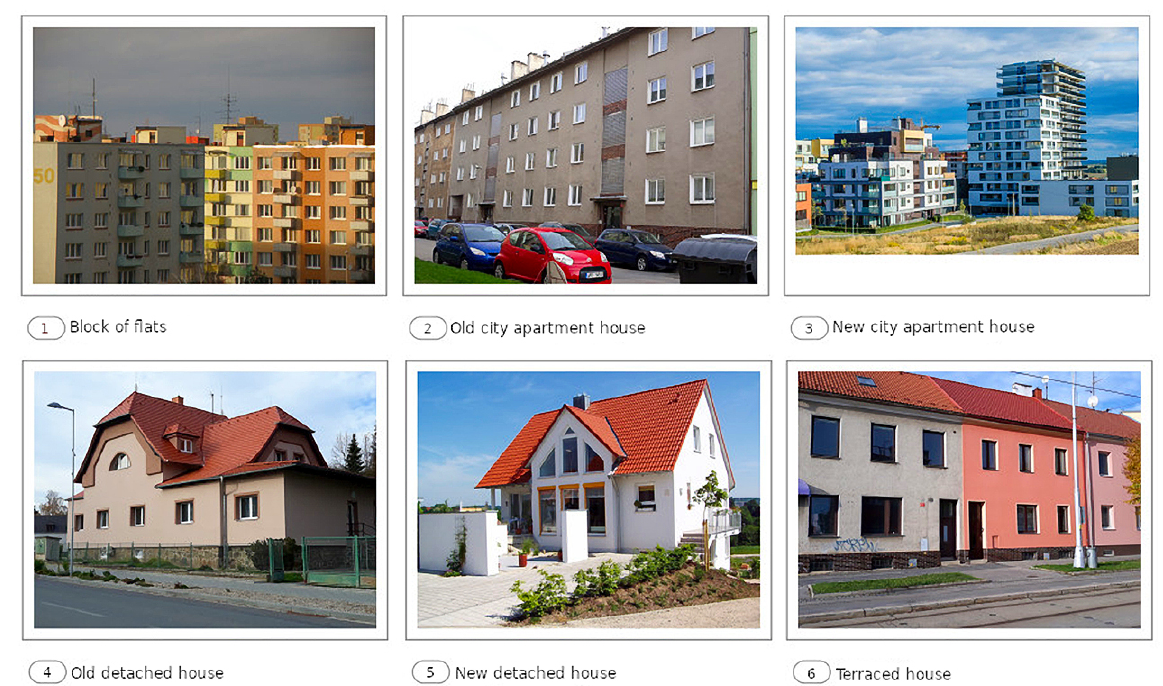
Figure 1. Types of housing developments including survey pictures